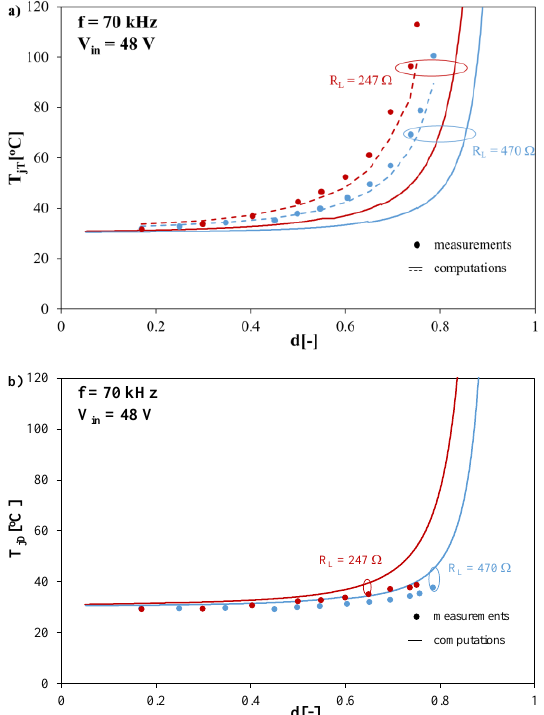
Figure 10. Measured and computed dependences of the IGBT junction temperature ( a ) and the diode junction temperature ( b ) on the duty cycle of the control signal of the IGBT in the investigated converter.